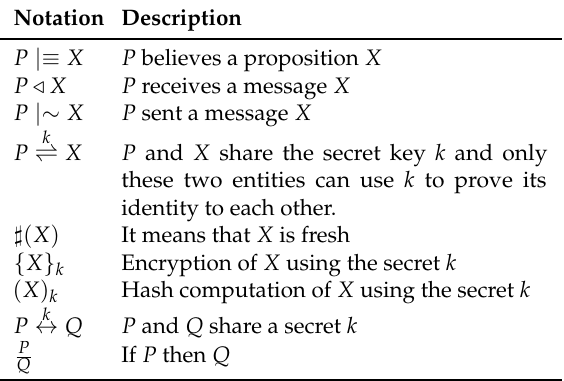
Table 2. BAN-logic